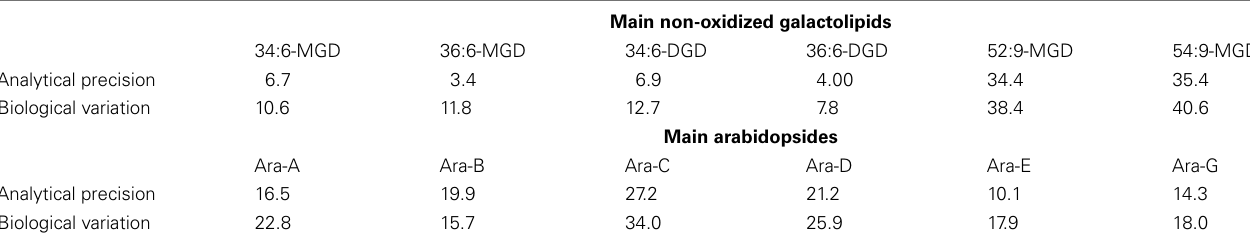
Table 7 | Calculated coefficients of variation (CV) of the analytical precision and biological variation using the established HPLC/MS 2 -based method.